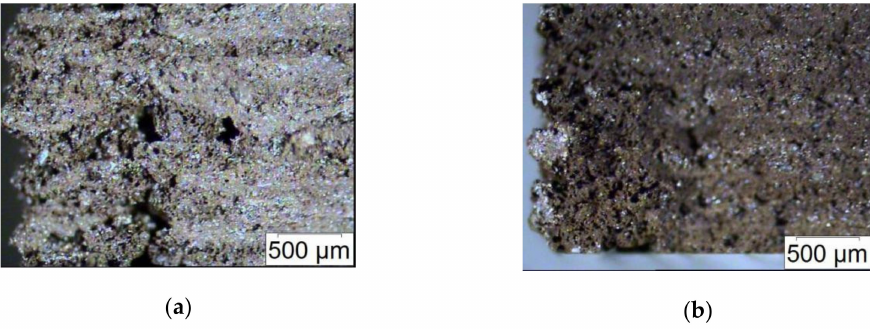
Figure 8. Specimen cross section after mechanical testing of a composite with 30 vol.% ferrite: ( a ) tensile test and ( b ) bending test. Table 2. Ultimate stress (average values) of all composites, derived from tensile and bending tests. Tensile Stress Number of Bending Composition (MPa) Samples